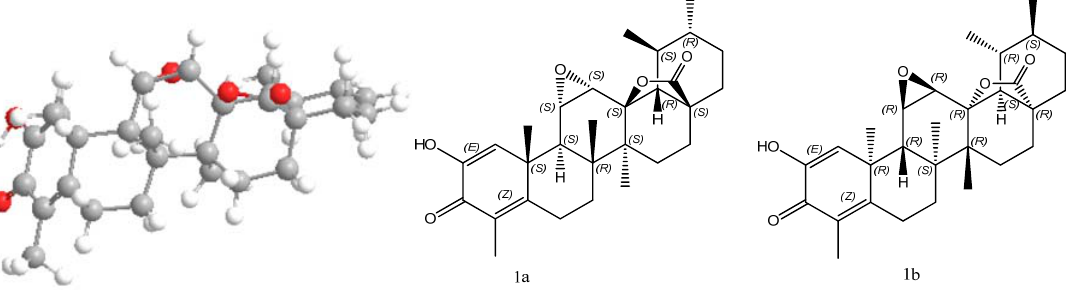
Figure 3. The optimized geometry of compound 1 and two possible structures 1a and 1b .